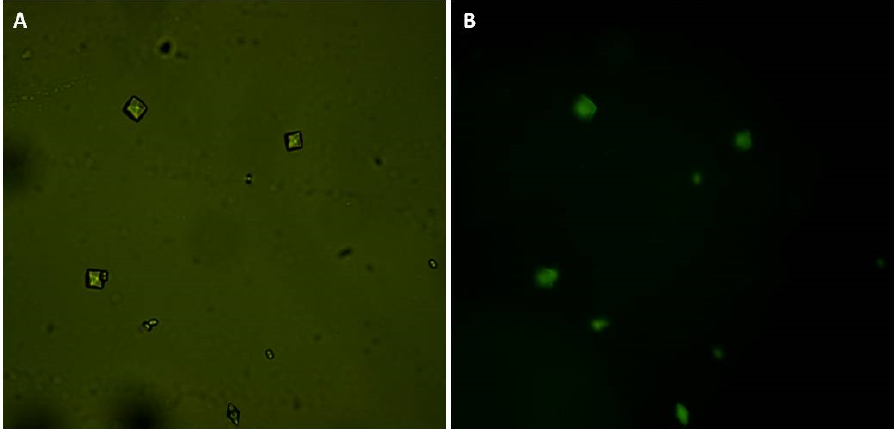
Figure 5. CaOx crystals formed in the presence of GB-FITC. (A) CaOx crystals observed under white light and (B) using fluorescent microscopy.